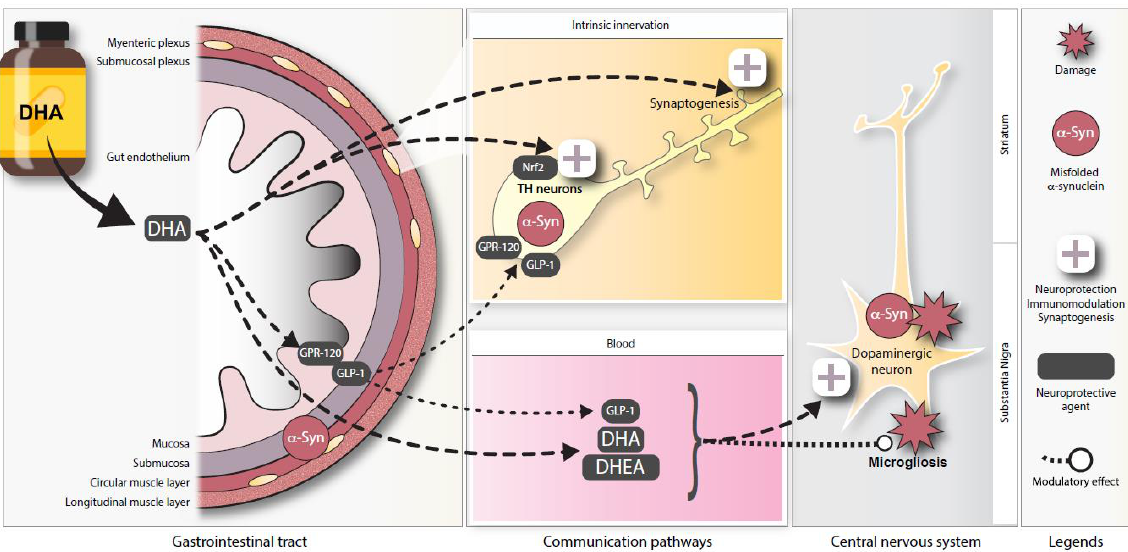
Figure 7. Schematic representation of potential neuroprotective pathways for DHA in the ENS . Illustration depicting a proposed model for DHA-mediated enteric neuroprotection in the Thy1-αSyn mouse model. Abbreviations: DHA, docosahexaenoic acid; DHEA, docosahexaenoyl ethanolamide; GLP-1, glucagon-like peptide-1; GPR120, G-protein coupled receptor 120; Nrf2, nuclear (erythroid-2) related factor-2; TH, tyrosine hydroxylase.